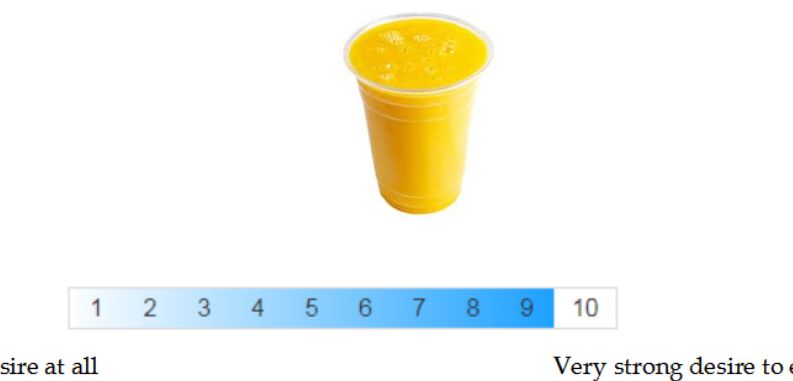
Figure A7. The picture of mango products (Solid food).